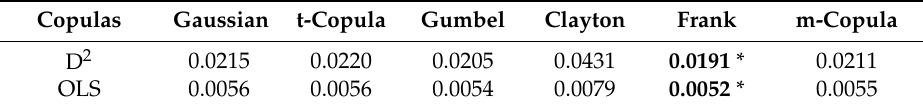
Table 6. Evaluation results of copula functions.